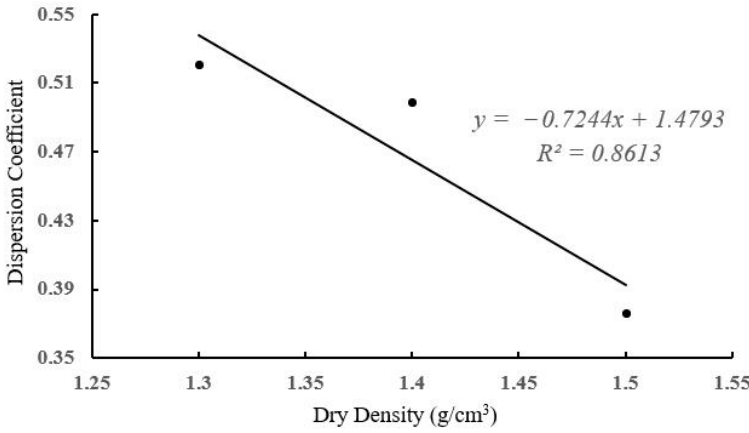
Figure 10. One-dimensional di ff usion coe ffi cients of coral sands with di ff erent dry densities.